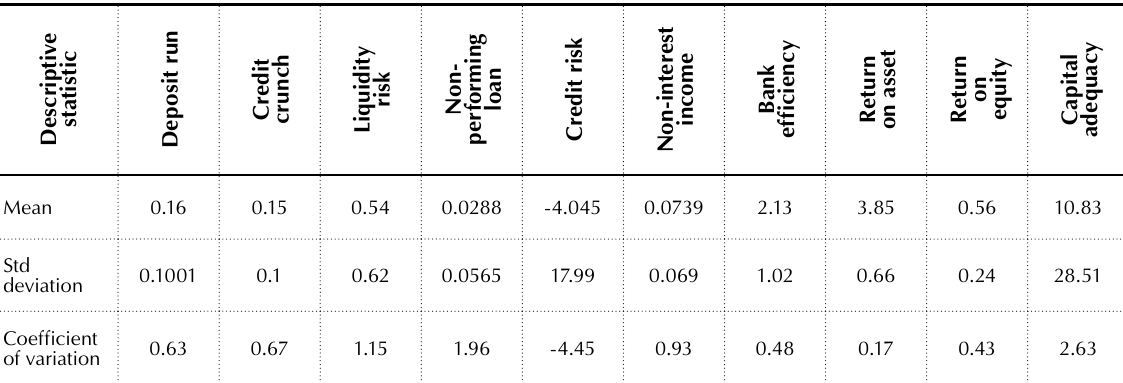
Table 16. Descriptive statistics for credit risk and liquidity crunch and AIRCABS